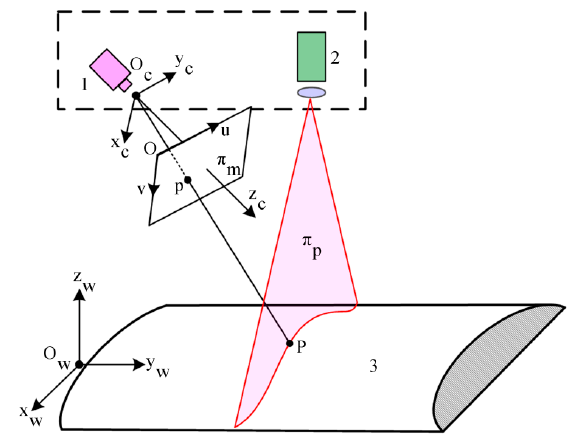
Figure 2. Structured-light vision model. (1) Camera; (2) laser projector; (3) measured object.